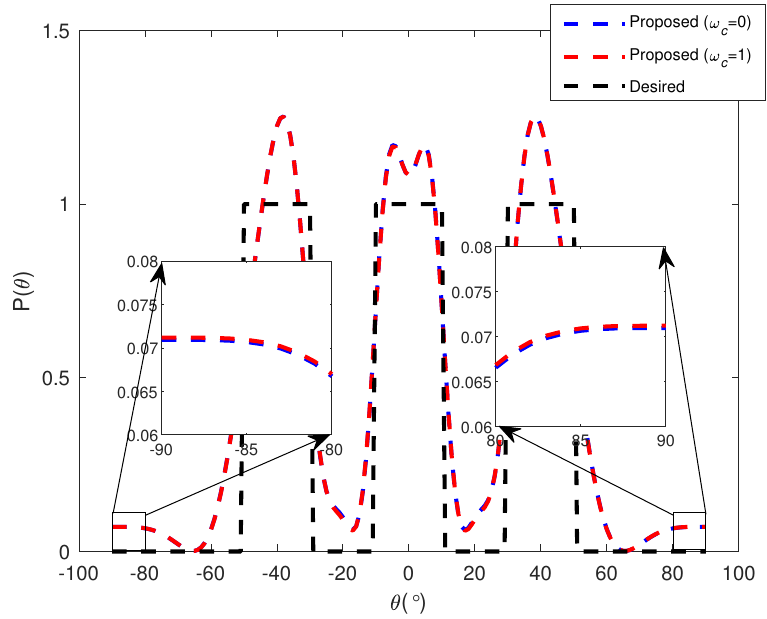
Figure 4. The beampattern matching performance comparison with ω c = 0 and ω c = 1.